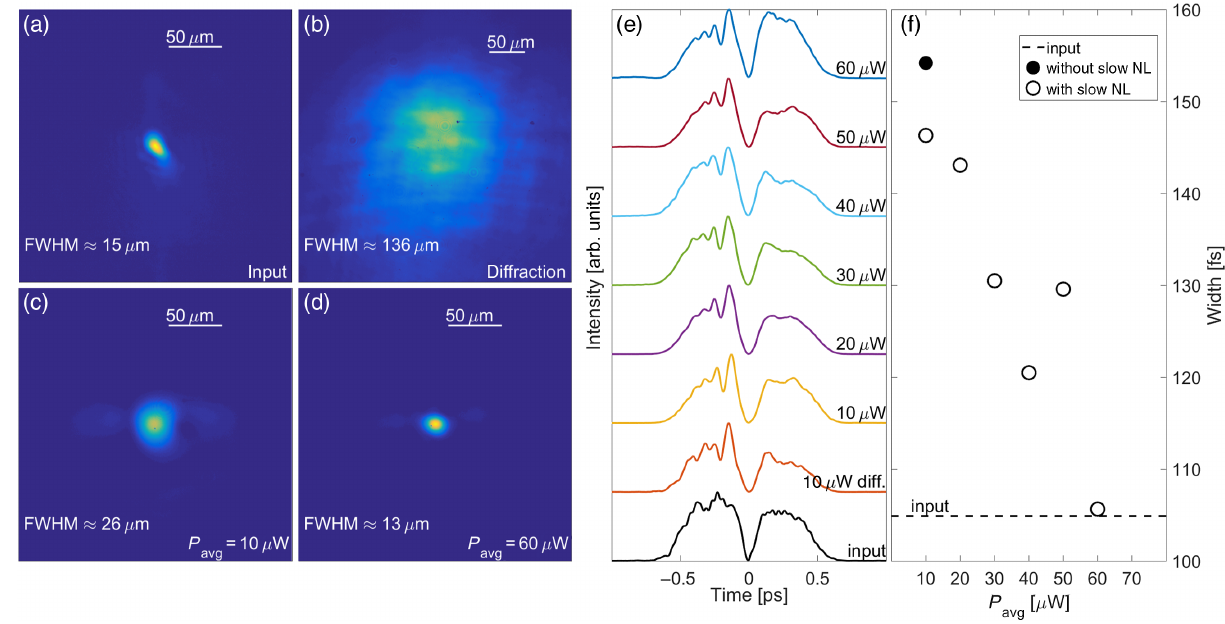
FIG. 3. Three-dimensional spatiotemporal pulse-train soliton in a short crystal ( L ¼ 6 mm). (a) Spatial intensity distribution at the input plane of the crystal (FWHM ≈ 15 μ m). (b) The intensity distribution at the output plane of the crystal under approximately linear propagation condition. The beam broadens to FWHM ≈ 136 μ m. Output plane intensity distributions when the screening self-focusing is turned on ( V ¼ 1800 V) at (c) 10 μ W and (d) 60 μ W averaged powers, demonstrating the transverse spatial self-trapping (FWHM ≈ 26 μ m and FWHM ≈ 13 μ m, respectively). (e) Reconstructed intensity pulse profiles of (bottom up) input pulse (black), ¼ 10 μ W (red), and spatially trapped beam with P ¼ 10 , 20, 30, 40, 50, and 60 μ W. (f) The duration of the diffracted beam with P avg avg dark notch as a function of average power demonstrating the temporal confinement. The horizontal dashed line corresponds to the duration at the input